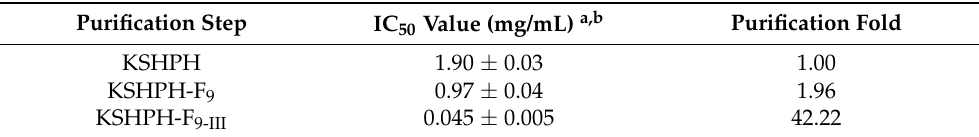
Table 2. Purification of the ACE inhibitory peptide of shrimp head hydrolysate from M. japonicus . Purification